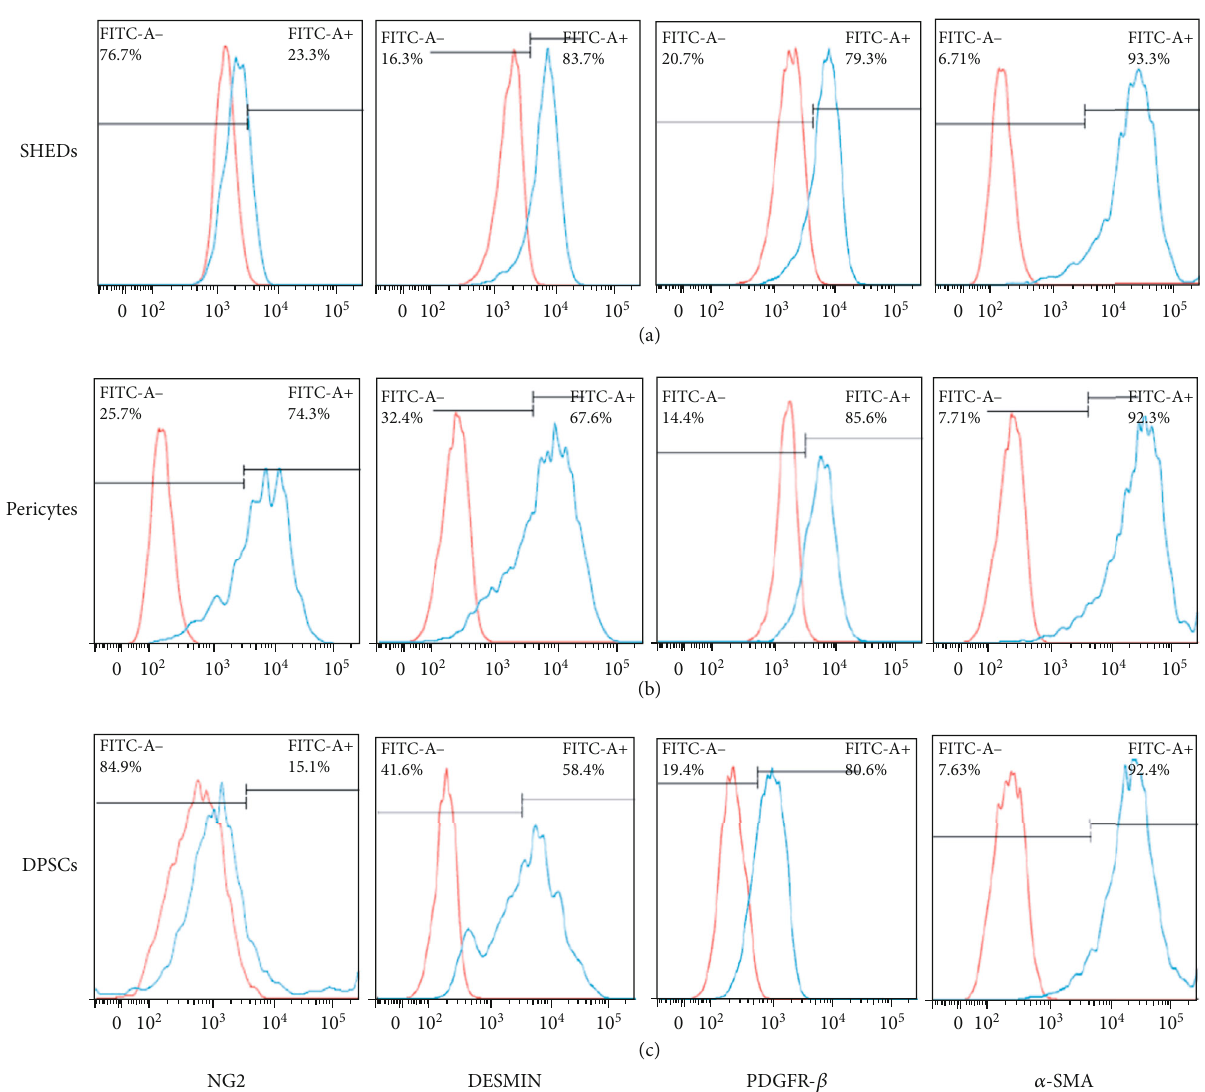
Figure 9: Immuno fl uorescence staining of pericyte-speci fi c markers of PDGFR- β , NG2, and DESMIN in stem cells from human exfoliated deciduous teeth (SHEDs), postnatal human dental pulp stem cells (DPSCs), and pericytes cultured in Melanocyte Growth Medium